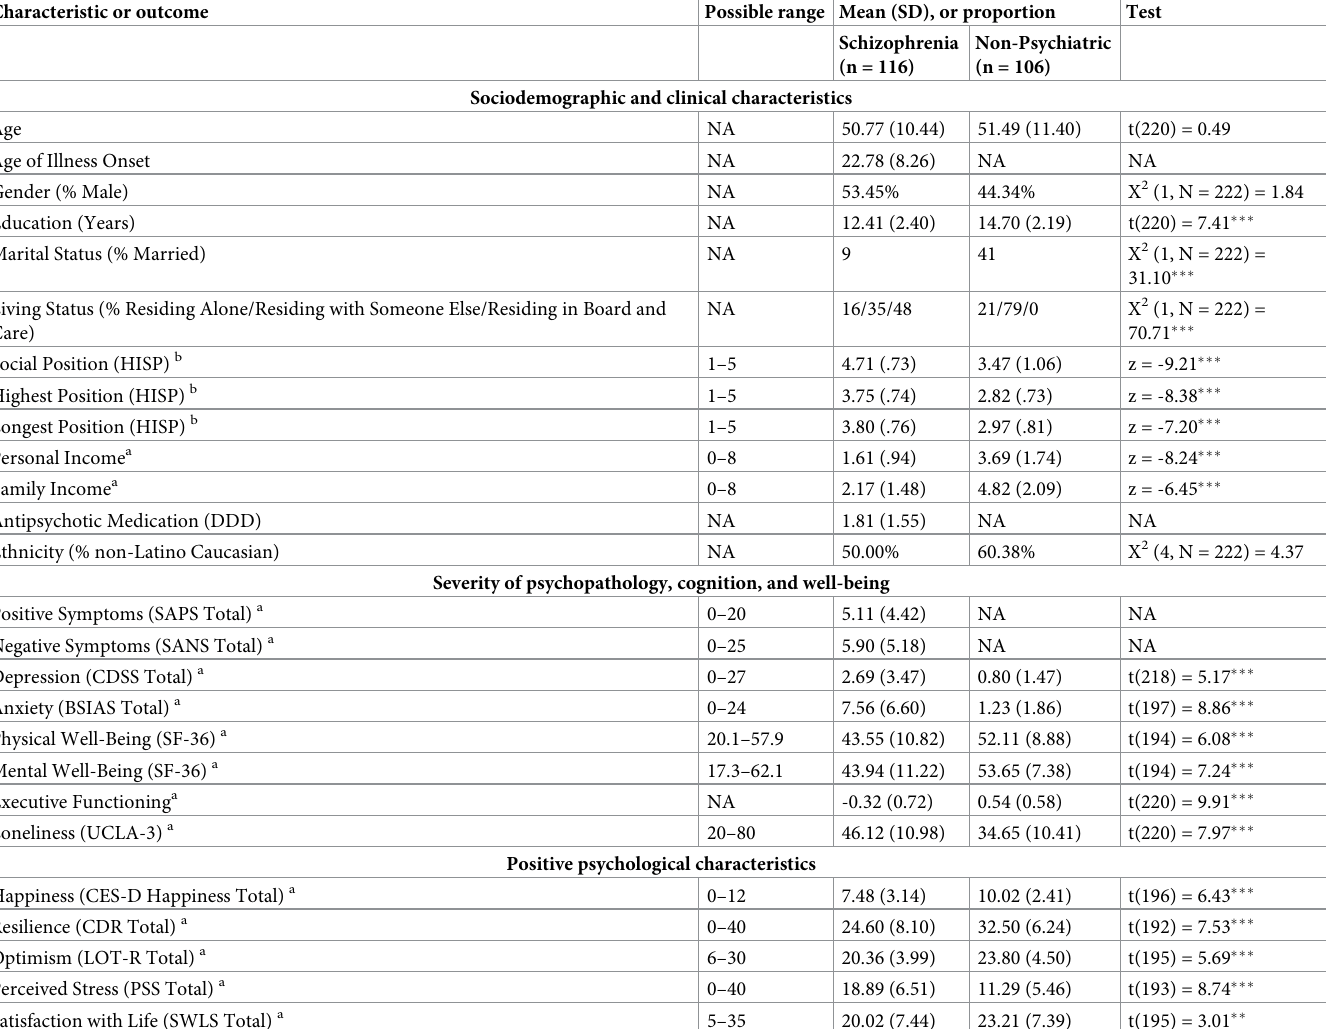
Table 2. Demographic, clinical, and positive psychological characteristics of the study